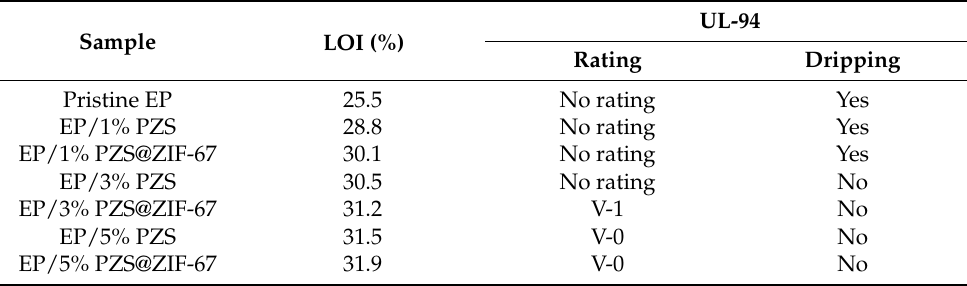
Table 4. LOI and UL-94 test results of EP and its composites.